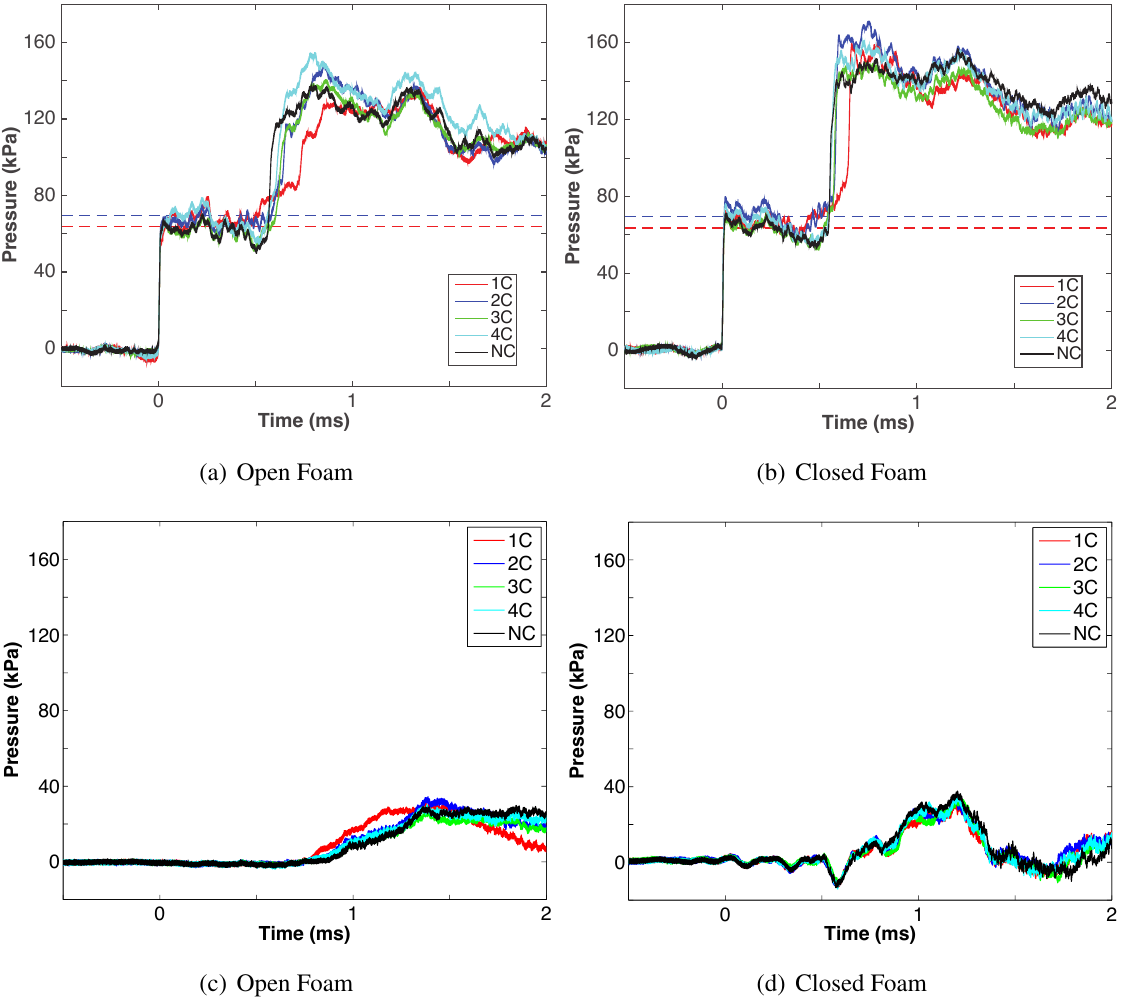
Figure 18. Comparison between open cell and closed cell. Top row: ( a ) and ( b ) show the incident and reflected shock wave. The dashed lines show analytical solutions for the range of Mach numbers measured in the experiment. Bottom row: ( c ) transmitted compression wave; ( d ) “piston like” driven compression